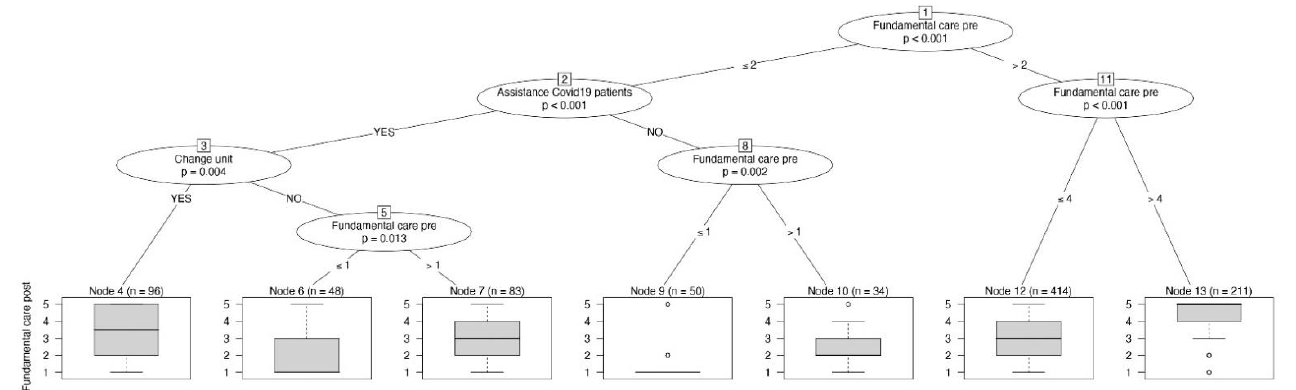
Figure 1. The conditional inference tree with the frequency of fundamental care tasks as dependent variable, reported at the bottom of the figure as boxplot.